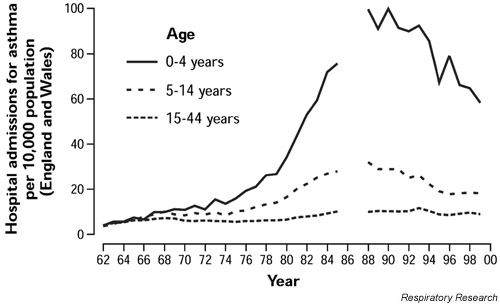
The rate of hospital admissions for asthma by age group from 1962 to 2000. Reproduced with permission from [3].